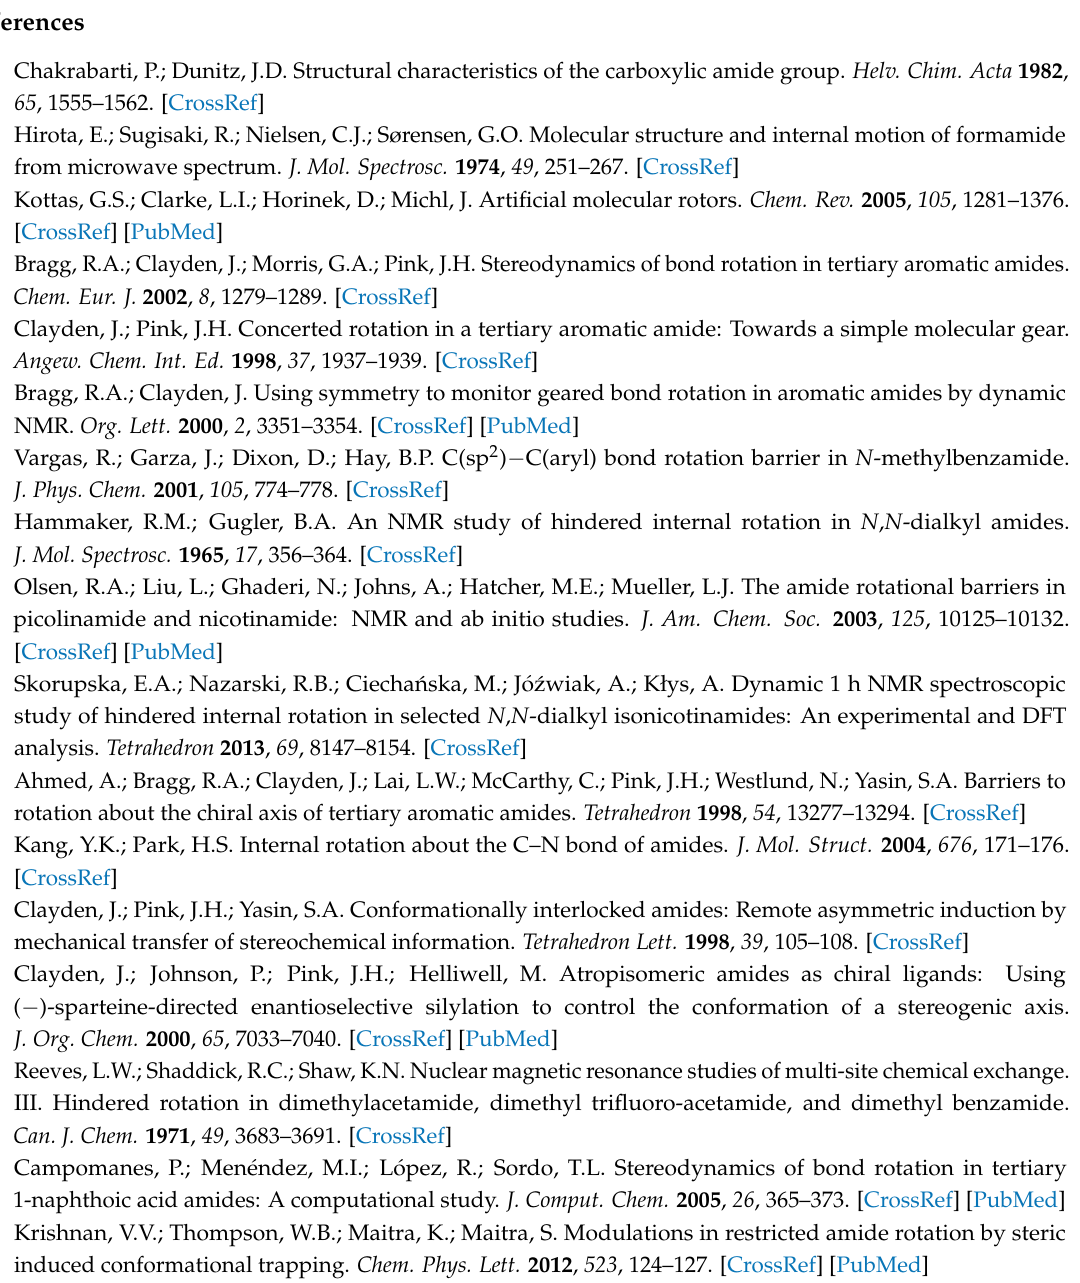
PCDEA, Table S9: Structure data of TS of the concerted Aryl-CO/C-N bond in NCDEA and PCDEA, Table S10: Structure data of TS of the concerted Aryl-CO/C-N bond of 2D PES in NCDEA and PCDEA, Table S11: Electron density of rotating